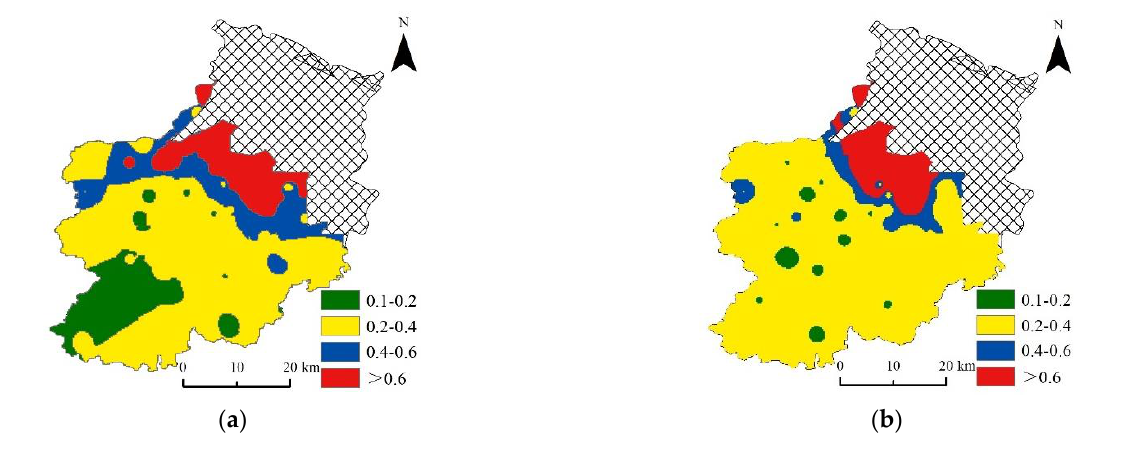
Figure 2. Spatial distribution of surface soil salinity: ( a ) spring; ( b ) summer.